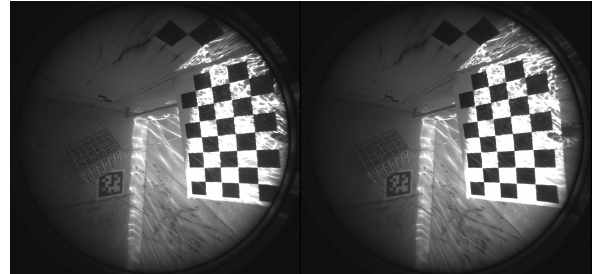
Figure 2. Stereo camera view of the calibration